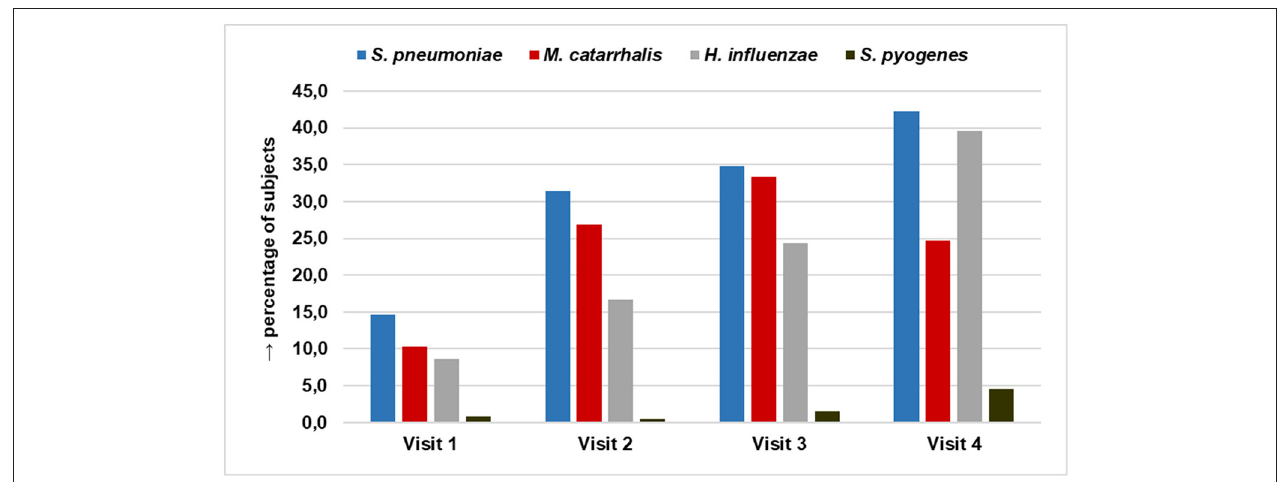
FIGURE 3 | Percentage of nasopharyngeal colonization by S. pneumonia , M. catarrhalis , H. influenza , and S. pyogenes among 2–60 month old children in the course of the study.